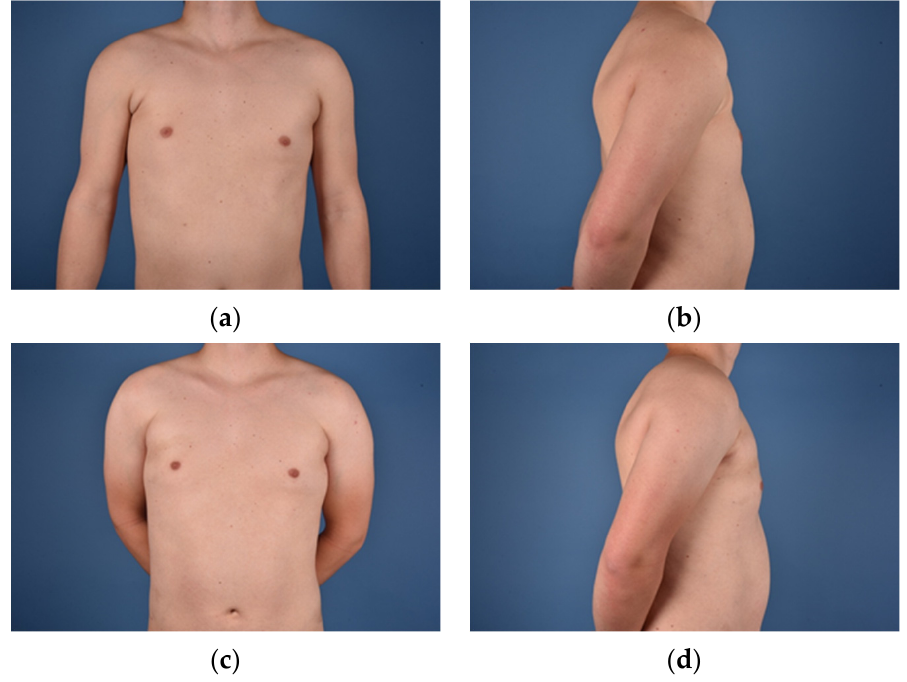
Figure 6. ( a ) = Male patient (25) with Grade I deformity; ( b ) = Preoperative side view; ( c ) = 17 months after 2× lipofilling (220 mL total); ( d ) = Postoperative side view.